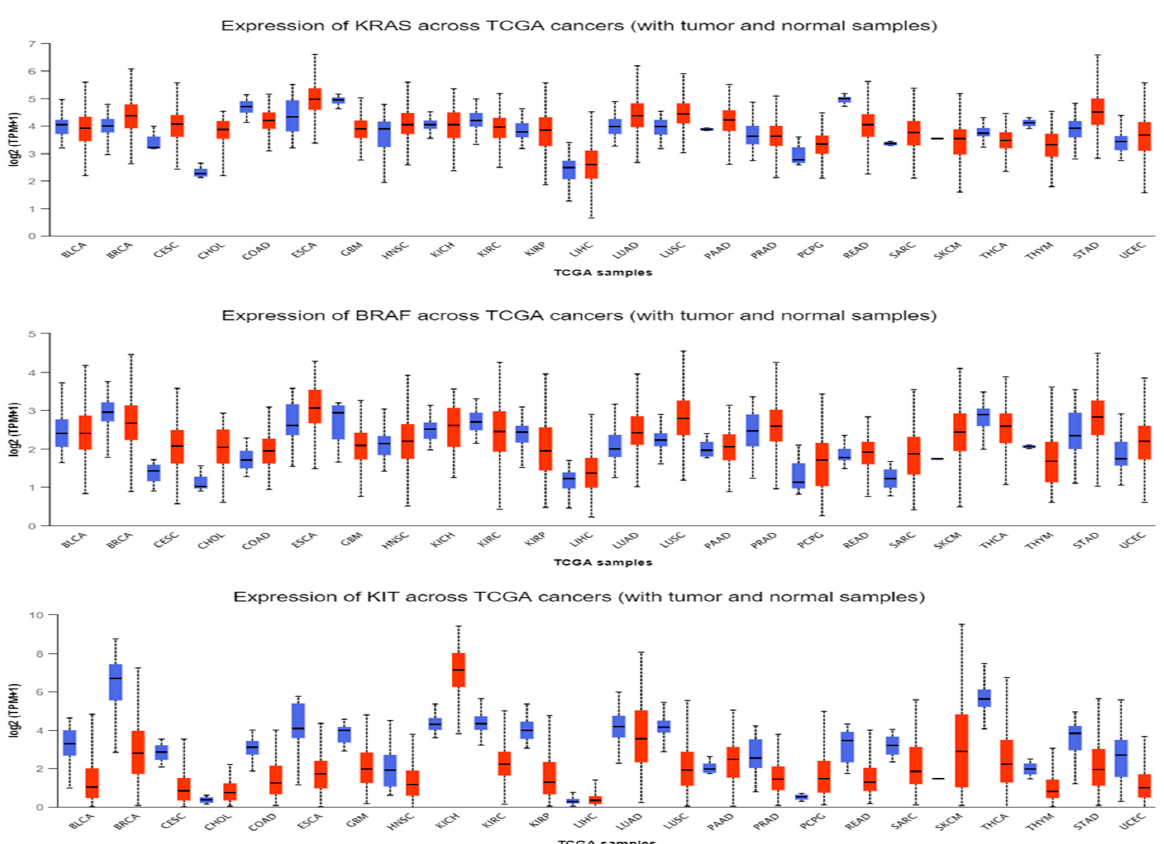
Figure A2. Expression levels of KRAS, BRAF, and KIT across human cancers (blue bars: normal tissue, red bars: tumor tissue).